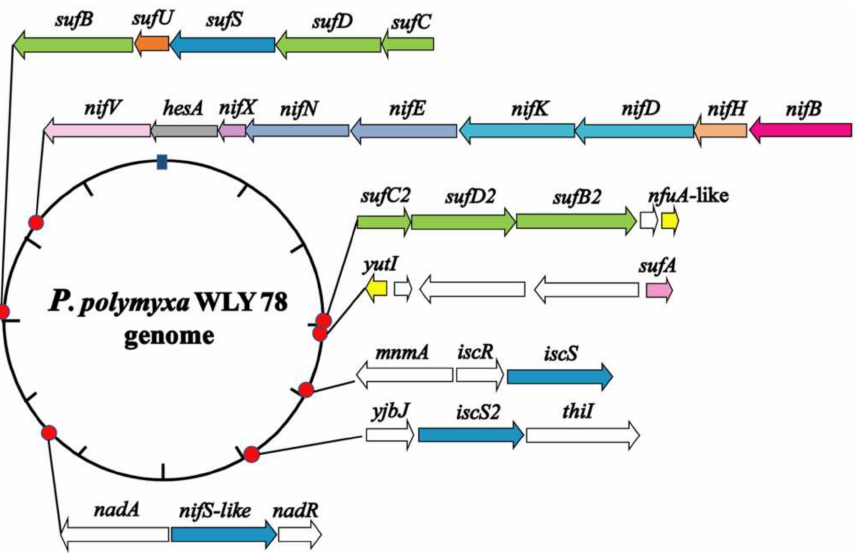
Figure 1. Genomic location of the Paenibacillus polymyxa WLY78 nif gene cluster and the putative genes involved in Fe–S cluster biogenesis. The schematic diagram representation shows the relative location, size, and orientation of the genes, and relevant flanking